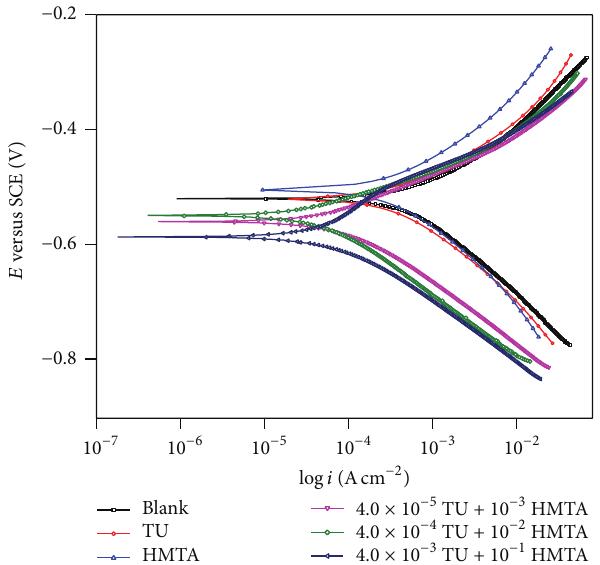
Figure 2: Anodic and cathodic polarization curves for N80 in 15% HCl in the absence and presence of various concentrations of TU and HMTA derivatives at 25 ± 1 ∘